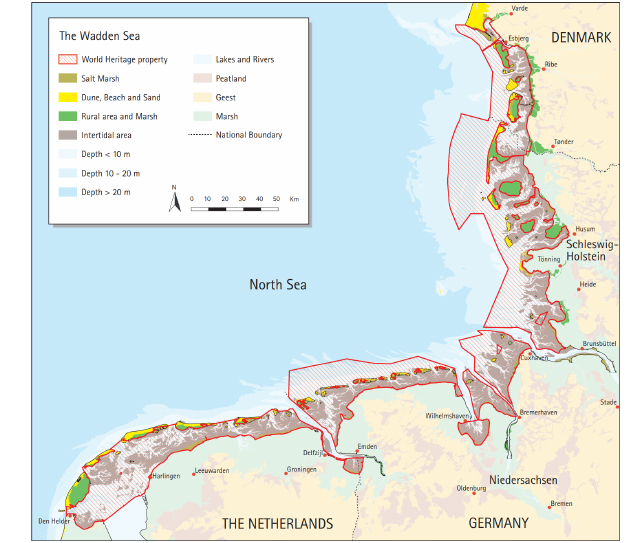
Figure 1. The Dutch Wadden Sea is part of a semi-contiguous UN- ESCO world heritage site that spans the coastline of The Nether- lands, Germany and Denmark. (© UNESCO; source: http://whc.